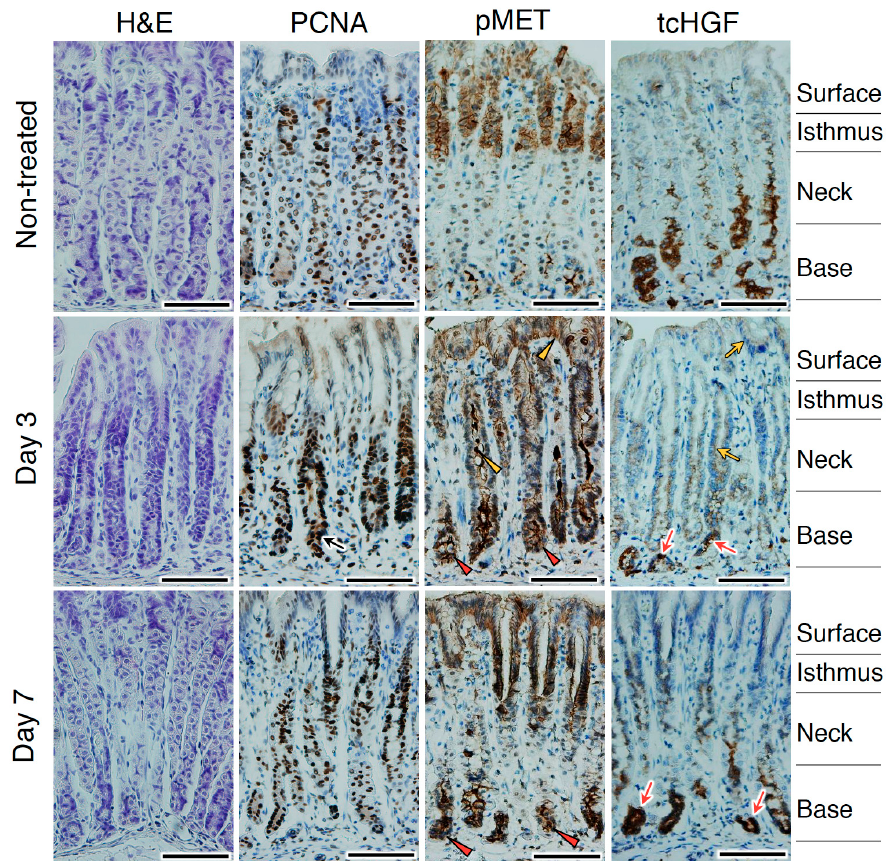
Figure 8. Changes in the localizations of tcHGF and pMET following stomach injury. hHGF-ki mice were subjected to a tamoxifen treatment. The black arrow indicates PCNA-positive proliferating cells. Red arrowheads and red arrows indicate pMET and tcHGF localizations, respectively, in the glandular base region. Yellow arrowheads and yellow arrows indicate pMET and tcHGF localizations, respectively, in the neck and/or surface regions. H&E, hematoxylin and eosin. Similar results were obtained in sections from two different mice independently subjected to tamoxifen treatment. Scale bars represent 200 µm.